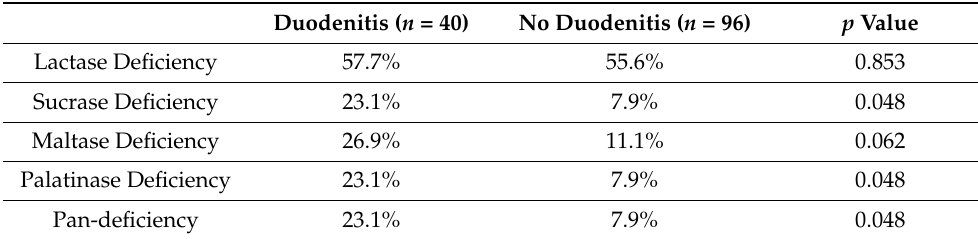
Table 5. Comparison of mean disaccharidase activity levels (umol/min/gram protein) in patients with Crohn’s disease with duodenitis and without duodenitis. Duodenitis ( n = 40) No Duodenitis ( n = 96) p Value Lactase Activity 12.4 ± 9.6 0.185 42.0 ± 18.5 Maltase Activity 131.7 ± 50.1 156.1 ± 54.3 Palatinase Activity 8.3 ± 4.2 10.1 ± 4.7 0.097 Data are indicated as mean +/ − SD; p values were calculated using the student’s t